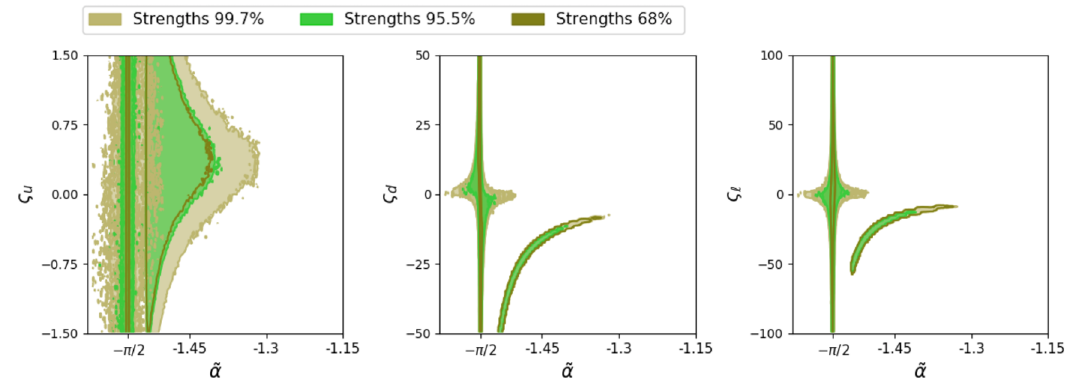
Figure 12. Constraints from Higgs signal strengths in the heavy scenario . One can distinguish the “right-branch” with ˜ α ≈ − π , corresponding to y h 2 − 2 for y h ≈ − 1 d,‘